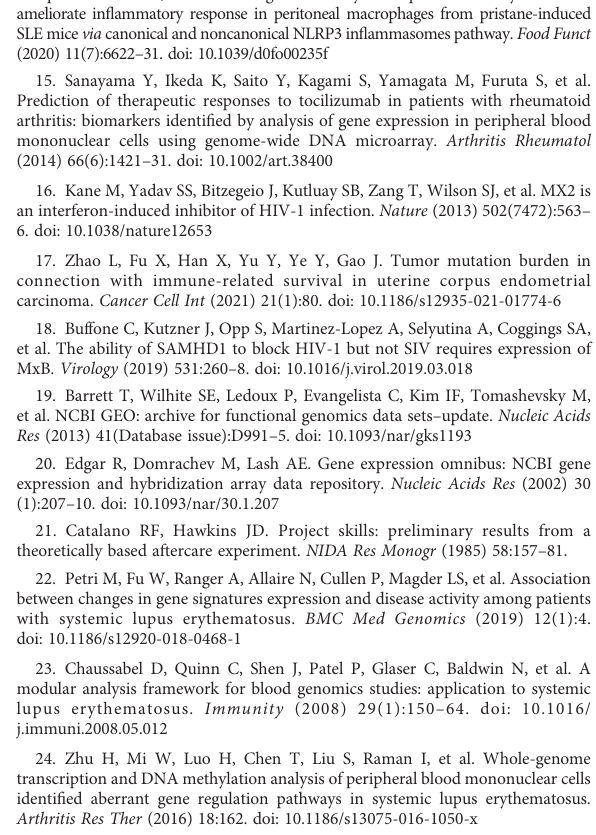
signaling pathway scores between high and low MX2 expression subgroups. (F) Comparison of MX2 expression between high and low subgroups of the NOD-like receptor signaling pathway scores. SUPPLEMENTARY FIGURE 7:5 Calculation of the difference of immune cells between different groups SUPPLEMENTARY FIGURE 7:6 Calculation of the correlation between MX2 and immune cells based on CIBERSORT (A) , xCell (B) and ImmuCellAI (C) algorithms. (D) , (E) Gene expression cluster map based on HPA database. SUPPLEMENTARY FIGURE 7:7 Calculation of the correlation between NOD-like receptor signaling pathway scores and immune cells based on ssGSEA (A) , xCell (B) , CIBERSORT (C) and ImmuCellAI (D) algorithms. SUPPLEMENTARY FIGURE 7:8 Transcription factor